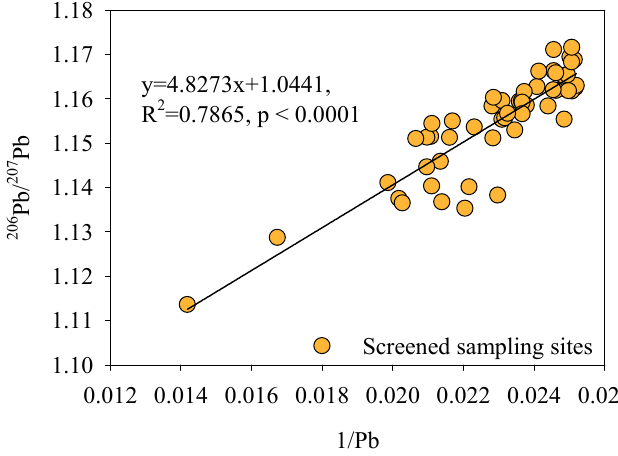
Figure 4. Relationships between Pb contents and 206 Pb / 207 Pb ratios after screening by RGB.